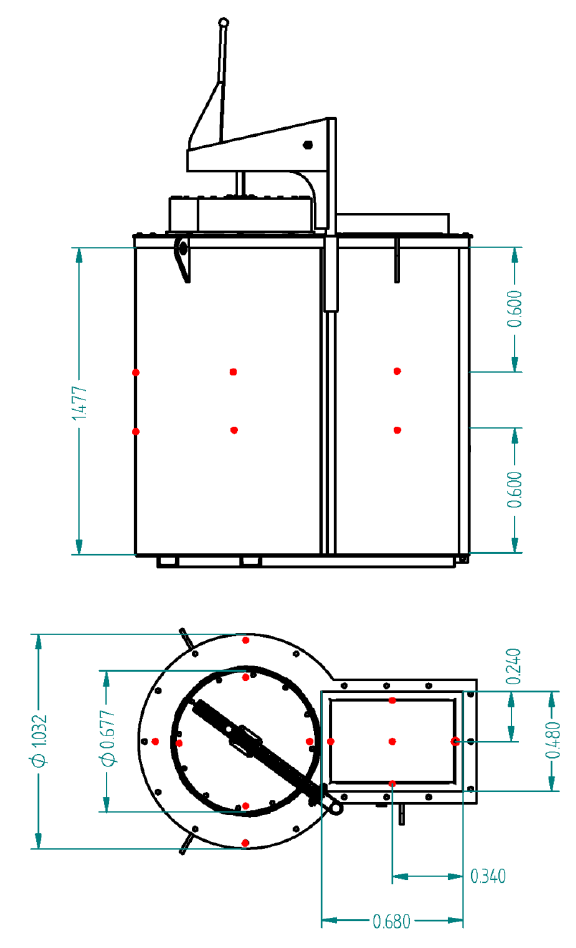
Figure 4. Points selected for temperature measurement on the exterior of the furnace walls (measurements in m).